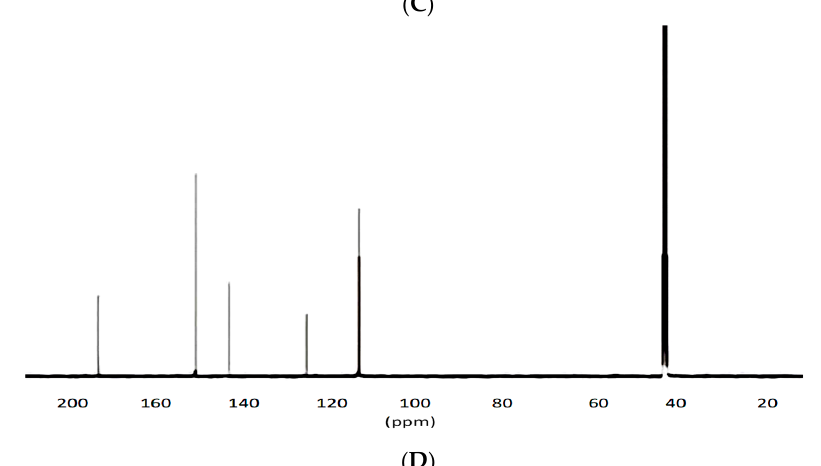
Figure 2. ( A ) Structure; ( B ) FTIR analysis; ( C ) 1 HNMR; ( D ) 13 C NMR, analysis of gallic